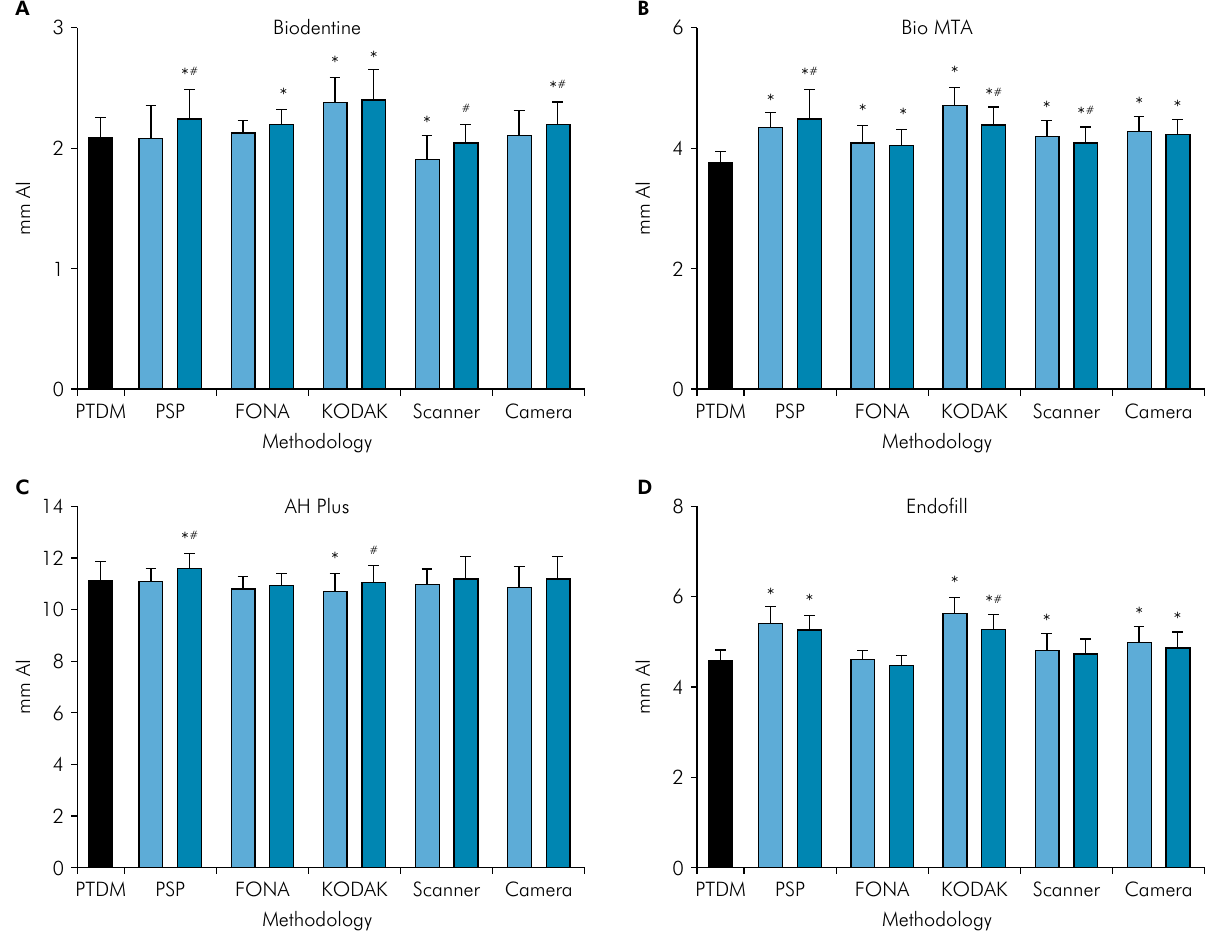
Figure. Mathematical comparison between the quadratic model (light blue) and linear model (blue) for radiopacity (mean and SD). ODU values obtained with the PTDM were converted to grayscale and compared with the grayscale values of the PSP, FONA, KODAK, scanner and camera methodologies. *indicates significant differences between the methodology and PTDM. #indicates significant differences between each mathematical model for each methodology group. Millimeters of Aluminum = mm Al, PTDM = photo-densitometer, PSP = photosensitive phosphor plate, FONA = Fona CMOS sensor, KODAK = Kodak CMOS sensor, ODU = optical density